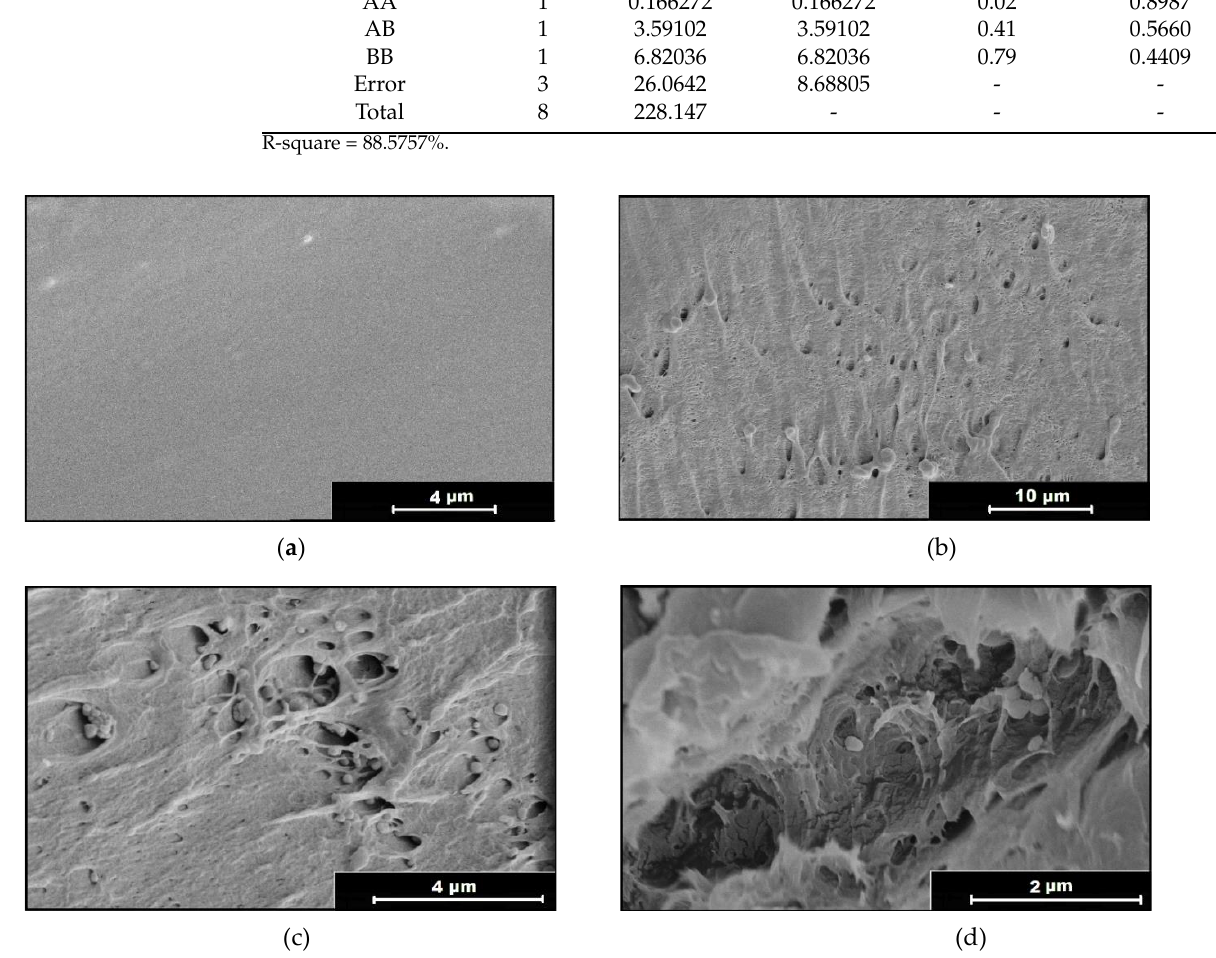
Figure 6. SEM images of ( a ) raw PLA filament (×1000), ( b ) PLA filament under scCO 2 at 75 °C and 250 bar (×2400), ( c ) PLA filament impregnated with ketoprofen at 35 °C and 100 bar (×10000), and ( d ) PLA filament impregnated with ketoprofen at 75 °C and 250 bar (×20000). All are transversal sections of the polymer filaments.